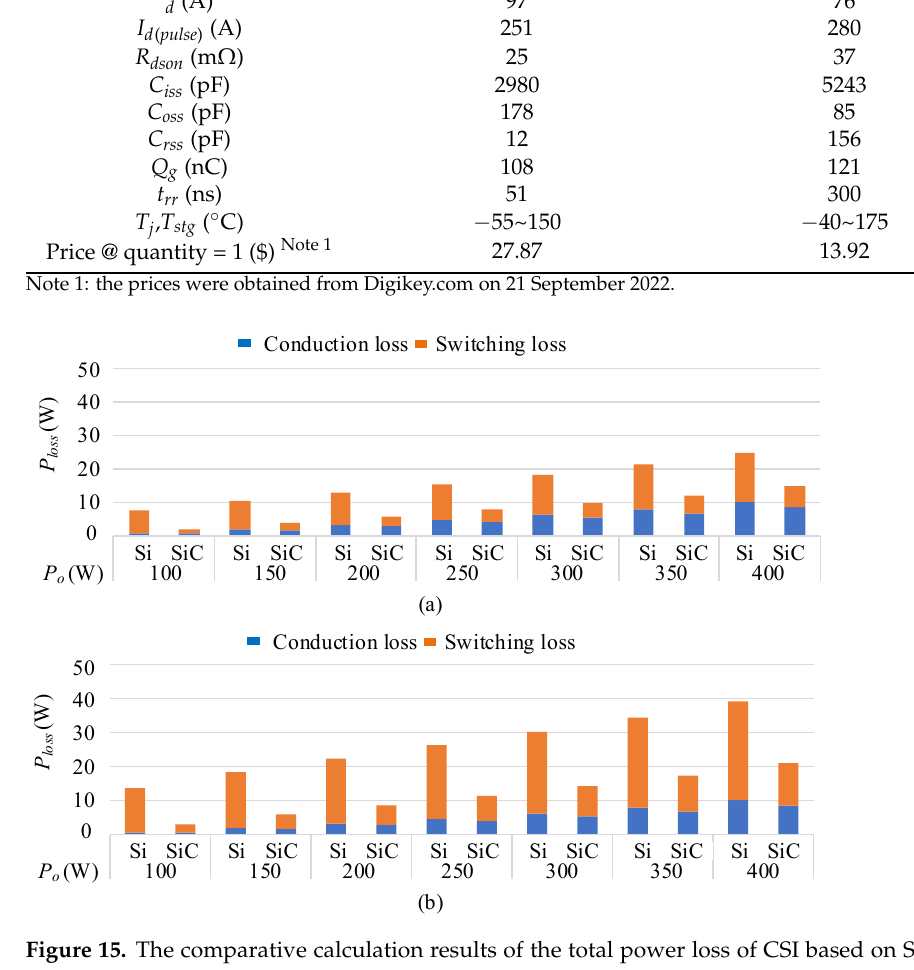
Figure 17. The power efficiency comparison between the SiC- and Si-based CSIs: ( a ) the power effi- ciency versus the output power (when f s = 10 kHz, U dc = 100 V); ( b ) the power efficiency versus the switching frequency (when R load = 20 Ω , U dc = 100 V); ( c ) the power efficiency versus the output power (when f s = 10 kHz, U dc = 400V); ( d ) the power efficiency versus the switching frequency (when R load = 20 Ω , U dc = 400 V). 4. Simulation and Experimental Verification